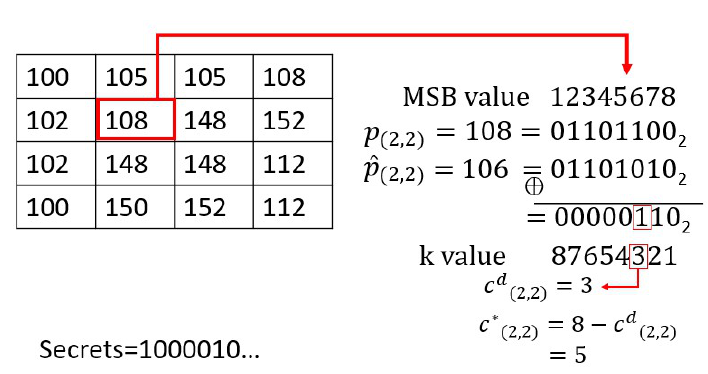
Figure 1. A sample prediction for a complex